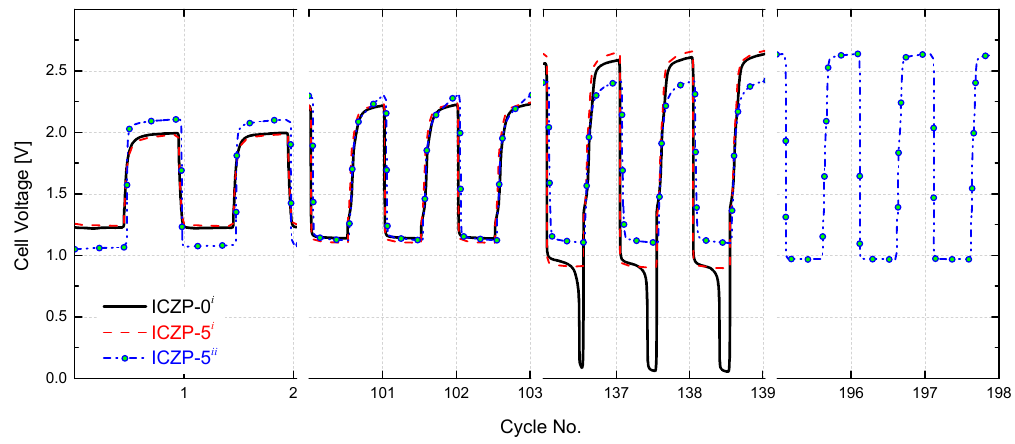
Figure 7. Cell voltage features for uncoated (ICZP-0) and 5 wt. % ionomer-coated (ICZP-5) Zn particles in 6.6 M KOH ( i : blank) and modified ( ii : 4s-2) aqueous alkaline electrolytes accelerated cycled at current density j d = j c = 5 mA cm − 2 for t d = t c = 10 min (capacity (d/c) = 2.1 mAh).